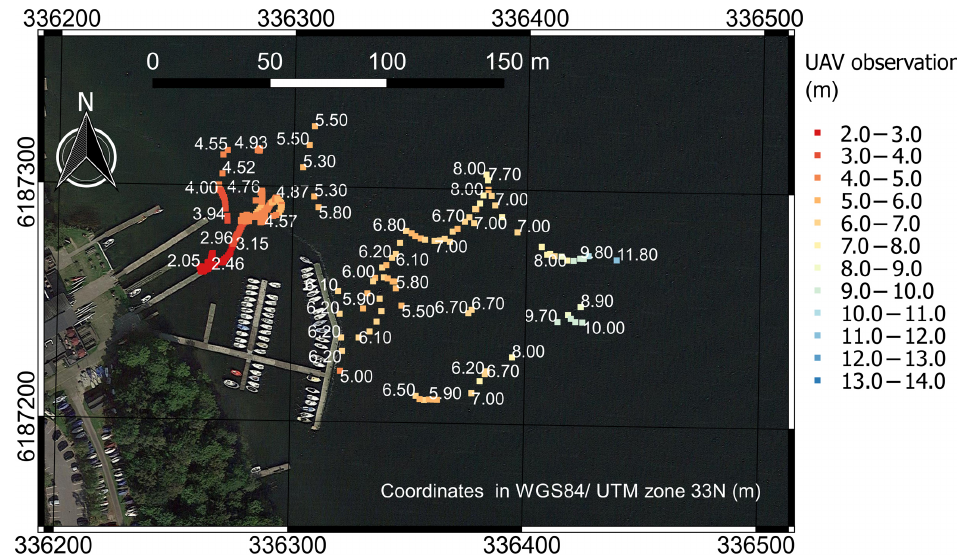
Figure 9. Water depth (m) observations retrieved in Furesø with the the sonar tethered to the UAV.